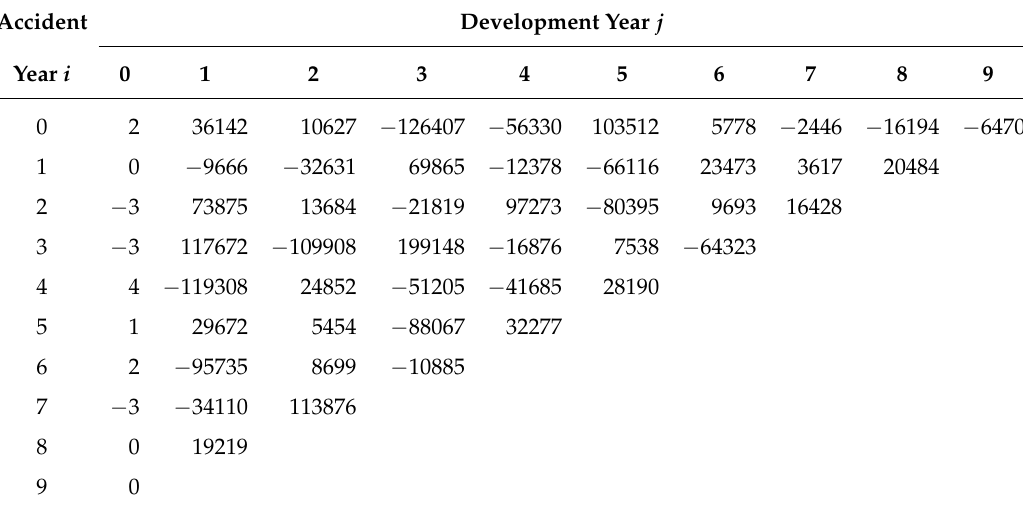
Table 4. K ALMAN outlier